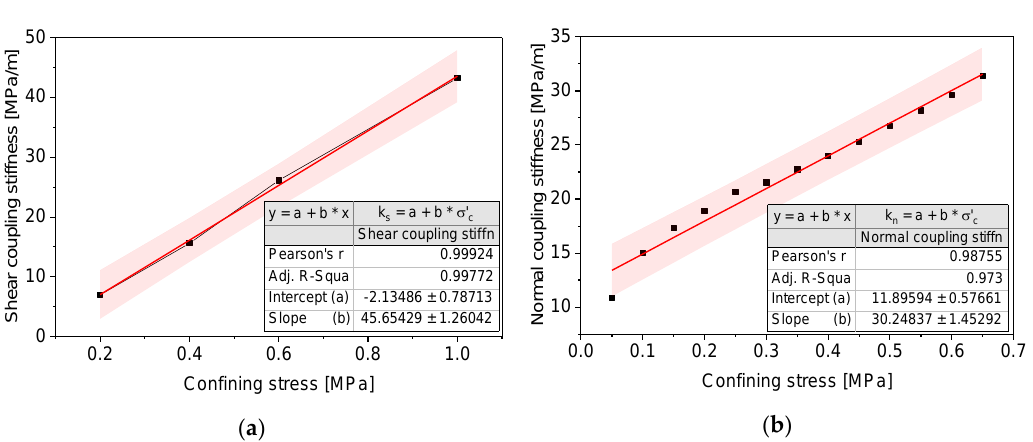
Figure 4. Linear regression models with confining stress: ( a ) shear coupling stiffness model; ( b ) normal coupling stiffness model.